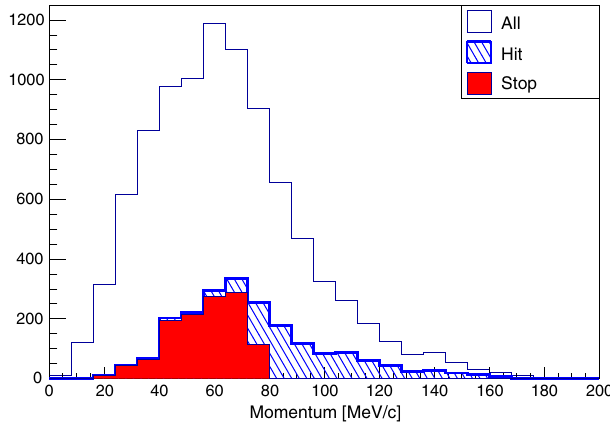
FIG. 5. Momentum distributions for all muons in a beam (white), the muons hitting the trigger counters (blue), and those stopped in the target